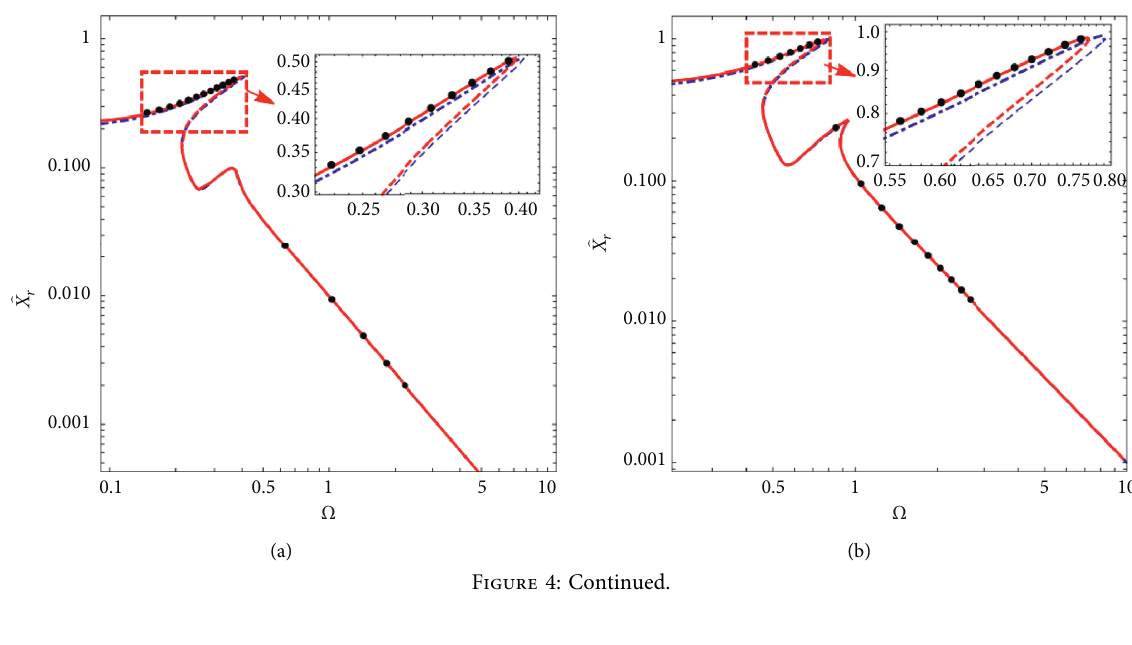
s 1 and m s 2 . (b) Amplitude-frequency curves of m s 2 ,